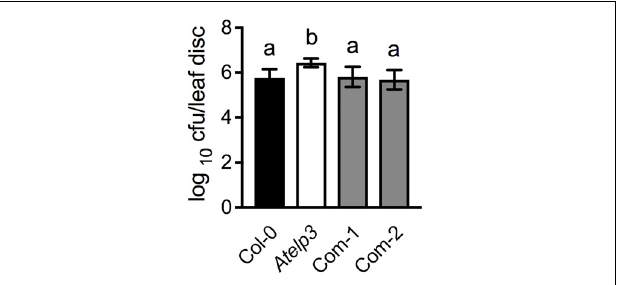
FIGURE 7 | Complementation of the disease susceptibility phenotype of the Atelp3 mutant by SlELP3 . Four-week-old wild-type Col-0, Atelp3 , and two independent complementation lines (Com-1 and Com-2) were inoculated with the bacterial pathogen Psm ES4326 (OD 600 = 0.0001). The in planta bacterial titers were determined 3 days post-inoculation. Data represent the mean of eight independent samples with SD. Different letters above the bars indicate significant differences (Tukey’s test, P <